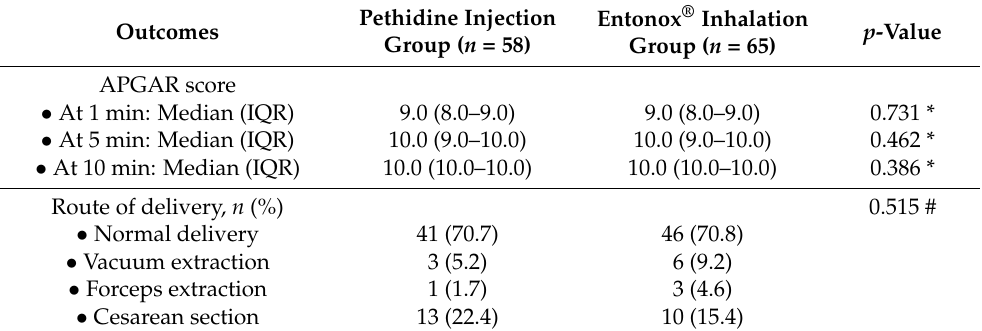
Table 5. Comparisons of Apgar score and route of delivery between pethidine group and Entonox ®